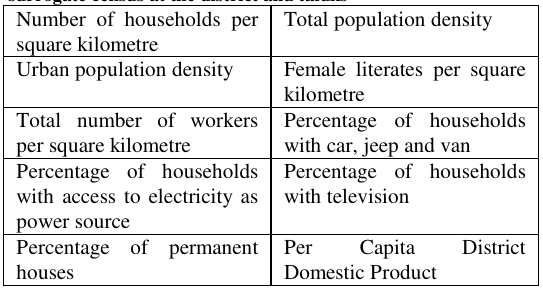
3.3 Application of the models to predict metrics at villages Number of female literates per square kilometre; percentage of households with cars, jeeps and vans; percentage of households with television; percentage of permanent